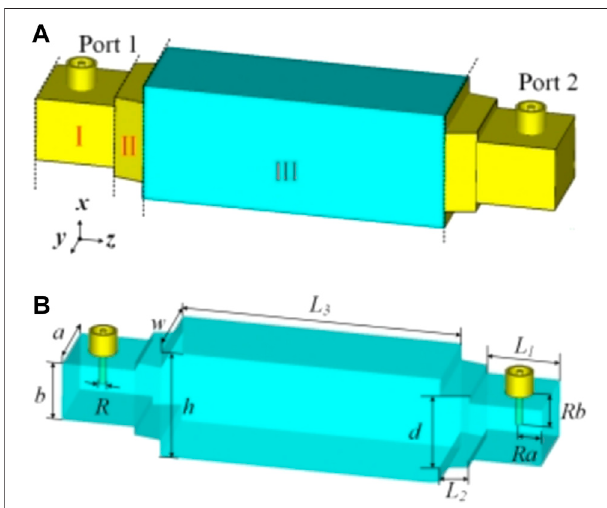
FIGURE 1 | (A) Designed structure of the dielectric rod waveguide and the conversion structure. The height of the metal coating is 0.035 mm. (B) Portion of the dielectric material of the entire structure and two coaxial cables at two ports, in which a (cid:1) 14.5, b (cid:1) 10.668, R (cid:1) 1.3, R a (cid:1) 5.7, R b (cid:1) 5.8, d (cid:1) 13.716, w (cid:1) 18, h (cid:1) 19.812, L 1 (cid:1) 13, L 2 (cid:1) 5, and L 3 (cid:1) 50 (all in mm). (Dielectric material is blue, and the metal is